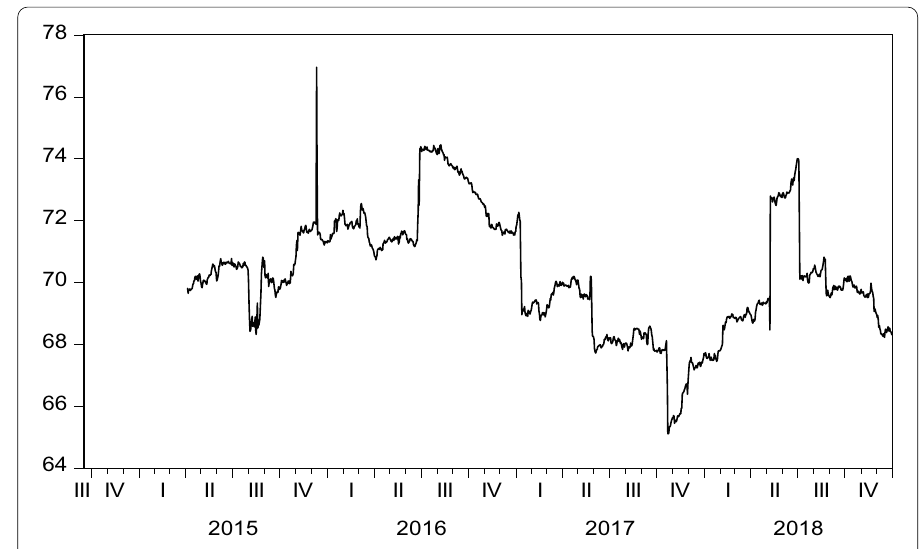
Fig. 1 Average volatility spillover—Bitcoin markets and foreign exchange pairs denominated in major trading currencies. The Y-axis depicts the volatility spillover values and the X-axis depicts the time